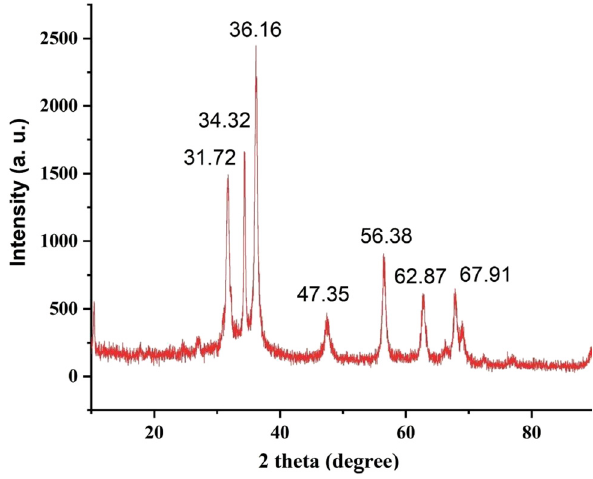
Figure 3: XRD data of biogenic ZnO